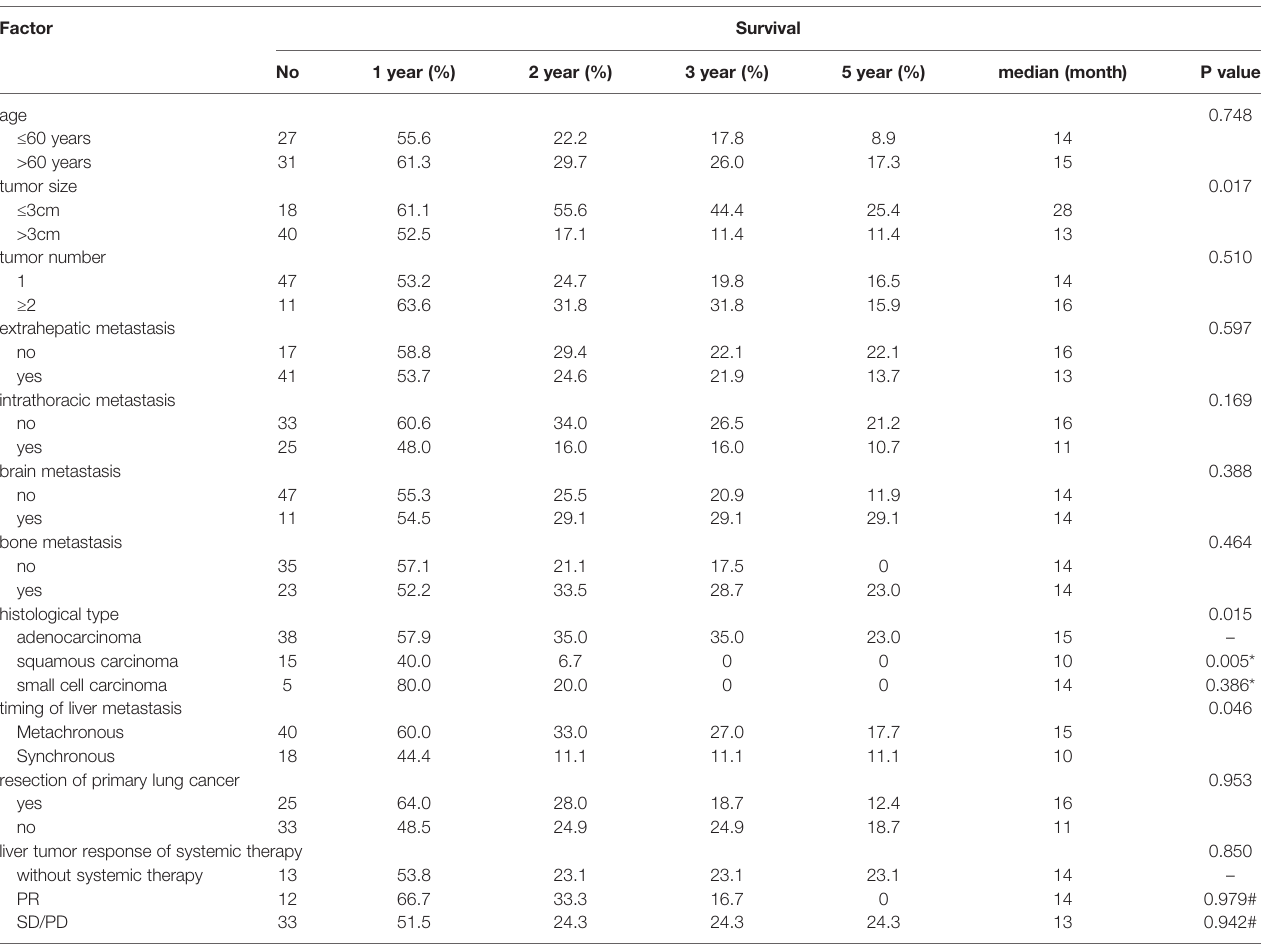
TABLE 1 | Univariable analysis of liver metastasis of lung cancer on overall survival.